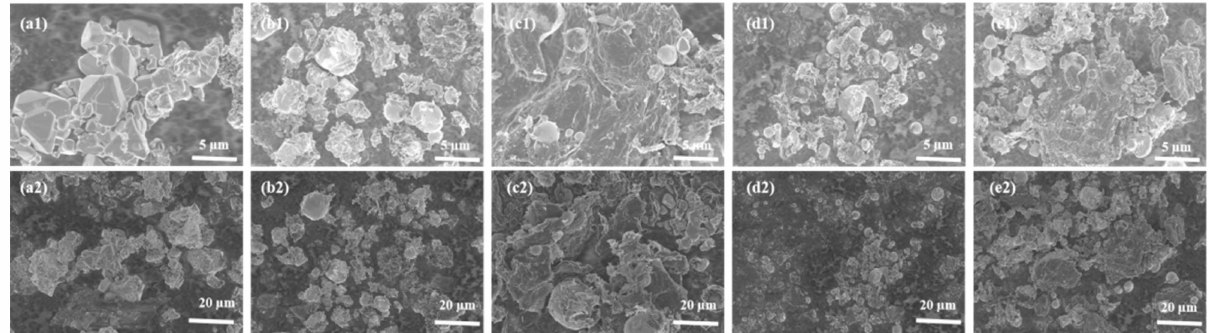
Figure 1. SEM images of rGO-SnO 2 -Fe 2 O 3 composites. ( a1 ) High magnification image of 10%SnO 2 - Fe 2 O 3 ; ( a2 ) Low magnification image of 10%SnO 2 -Fe 2 O 3 ; ( b1 ) High magnification image of 0.2%rGO- 10%SnO 2 -Fe 2 O 3 ; ( b2 ) Low magnification image of 0.2%rGO-10%SnO 2 -Fe 2 O 3 ; ( c1 ) High magnifi- cation image of 0.4%rGO-10%SnO 2 -Fe 2 O 3 ; ( c2 ) Low magnification image of 0.4%rGO-10%SnO 2 - Fe 2 O 3 ; ( d1 ) High magnification image of 0.6%rGO-10%SnO 2 -Fe 2 O 3 ; ( d2 ) Low magnification image of 0.6%rGO-10%SnO 2 -Fe 2 O 3 ; ( e1 ) High magnification image of 0.8%rGO-10%SnO 2 -Fe 2 O 3 ; ( e2 ) Low